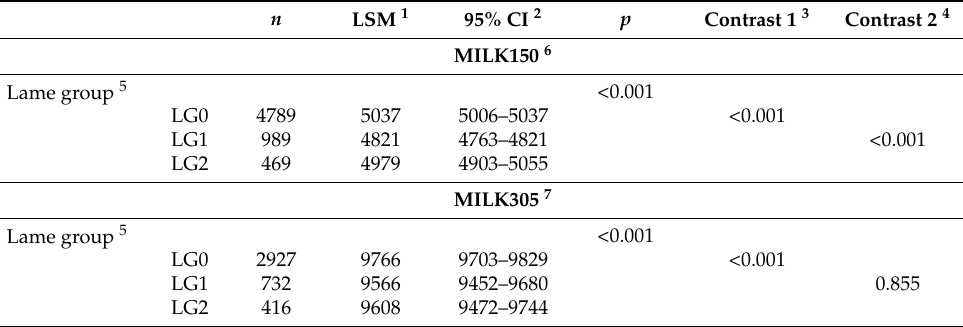
Table 2. Linear regression models assessed the association between the timing of lameness case occurrence in lactation milk yield in grazing dairy cows ( n = 6685 lactations for MILK150 and 4298 lactations for MILK305) from a commercial dairy herd evaluated for 7.5 years (January 2010–June